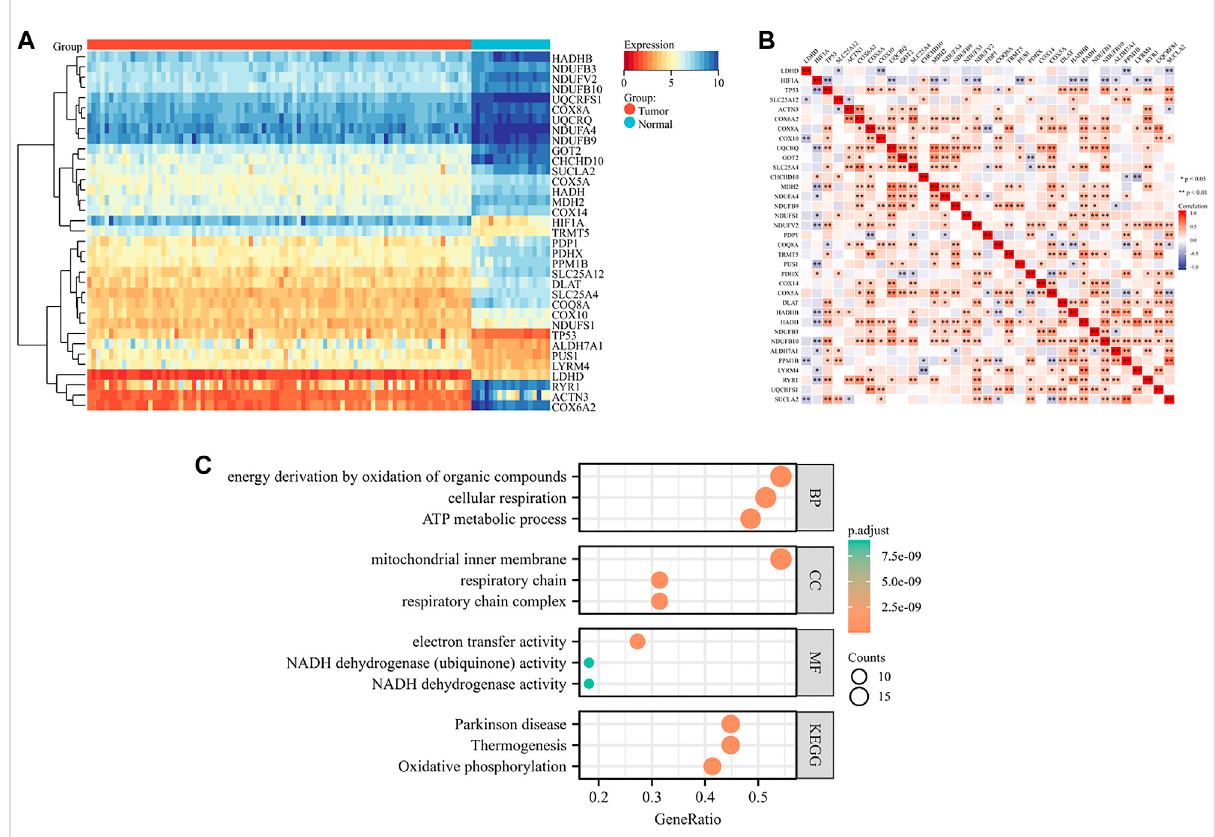
FIGURE 2 Identi fi cationandfunctionalenrichmentofDE-LRGsinEWS (A) .HeatmapillustratingtheexpressionofDE-LRGsineachsample (B) .Interaction plot of DE-LRGs in EWS (C) . GO terms and KEGG pathway